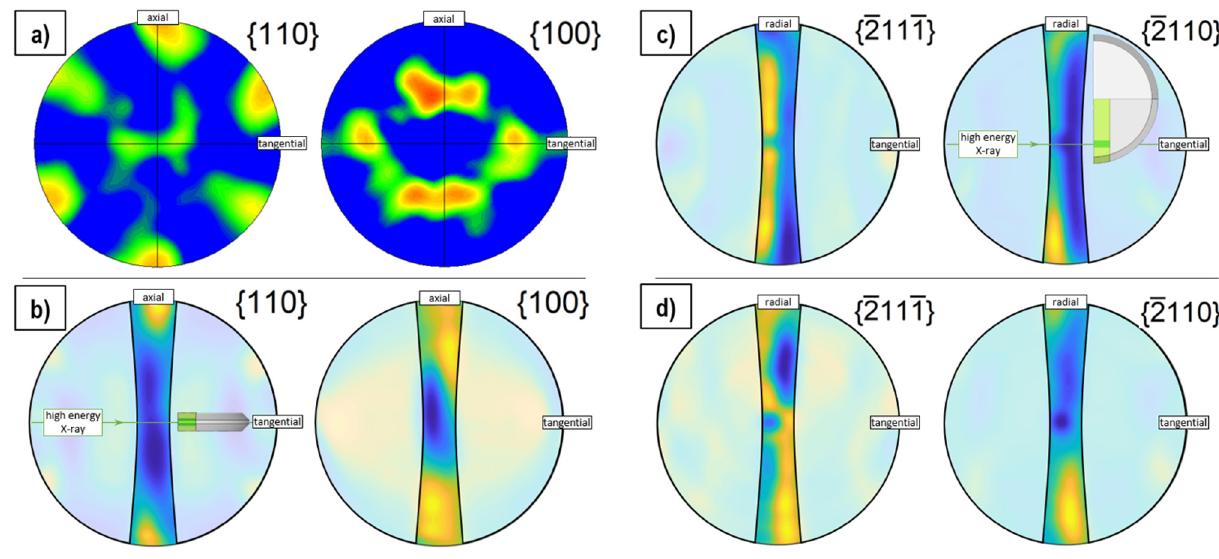
Figure 6. EBSD pole figure of Fe based on EBSD measurements ( a ). Pole figure representations of Fe reconstructed based on a HEXRD measurement of the HPT-deformed composite HPT3 ( b ) and a representation of the same sample and diffraction pattern for two SmCo 5 planes ( c ). Pole figure representation for the BM + HPT3 sample and the same SmCo 5 planes ( d ). An inset in the image ( b ) for the Fe phase and in ( c ) for the SmCo 5 phase visualizes the relative position of the HPT disc with respect to the incident X-ray beam and shown pole figures. The position of the HEXRD measure- ment within the sample is highlighted. The pole figure representations are partly covered with a transparent mask to lay the focus on the information obtained from less extrapolated areas.